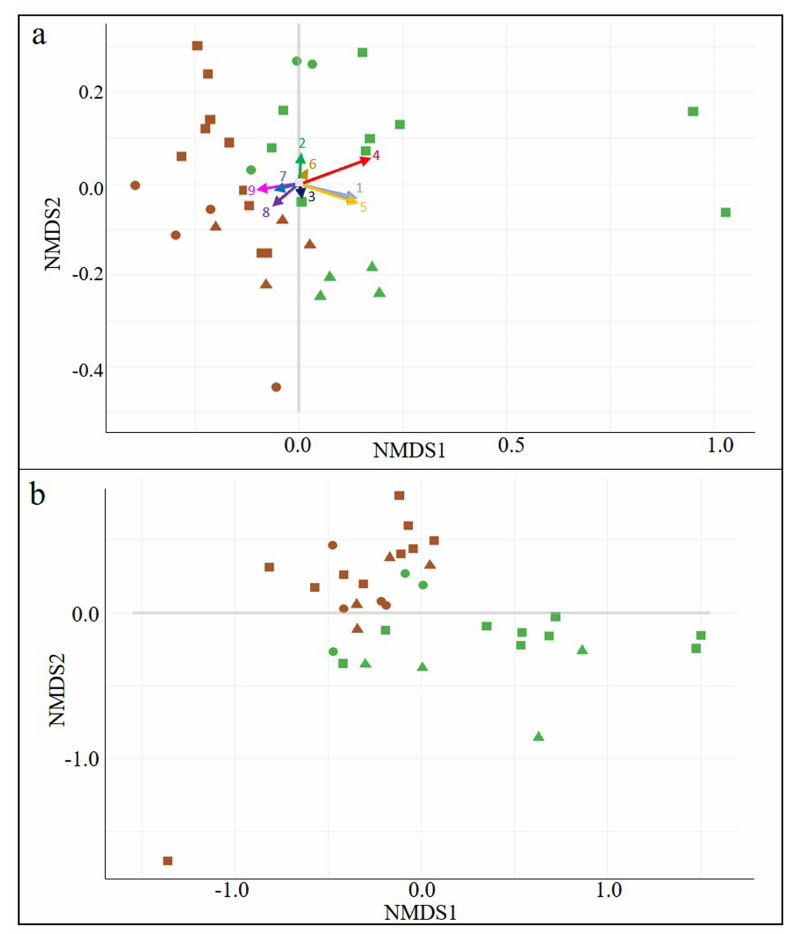
Figure 2. Beta diversity calculated on bacterial ( a ) and fungal ( b ) datasets shown in a non-parametric multi-dimensional scale (NMDS) using Bray-Curtis distance. The stress parameter used in the bacterial analysis to define the ordination quality was 0.160. Significant differences were found among different season samples ( p -value = 0.001) and for samples of different soil types ( p -value = 0.058). Stress parameter used in the fungal analysis to define the ordination quality was 0.145. Significant differences were found among different season samples ( p -value = 0.001) and for samples of different soil types ( p -value = 0.052). Seasons (summer (brown) and winter (green)), oil types (calcareous ( ), clayey ( (cid:52) ) (cid:35) and sandy ( )). Figure 2a includes information on the contribution of some bacterial-derived (cid:31) soil-related metabolic functions, inferred from the taxonomical bacterial diversity using the Tax4Fun routine. The nine vectors showed were calculated from the relative abundance of metabolic enzymes (KEGG) corresponding to: (1) carbon organic formation; (2) carbon organic use; (3) nitrogen organic formation; (4) nitrogen organic use; (5) other; (6) phosphorus inorganic transport; (7) phosphorus organic transport; (8) sulfur organic formation; and (9) sulfur organic use. A detailed list of the metabolic enzymes (KEGG) included on each group is reported in Table